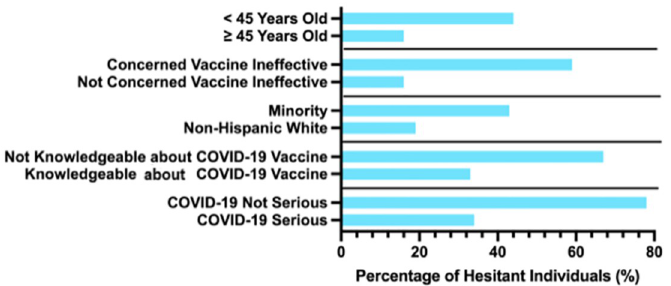
Fig 1. Bar graph of the percentage of hesitant individuals towards COVID-19 vaccine in eastern Pennsylvania with influential factors. Percentage of hesitant individuals towards the COVID-19 vaccine in Eastern Pennsylvania for each factor found to be significant during binary regression (N = 181).